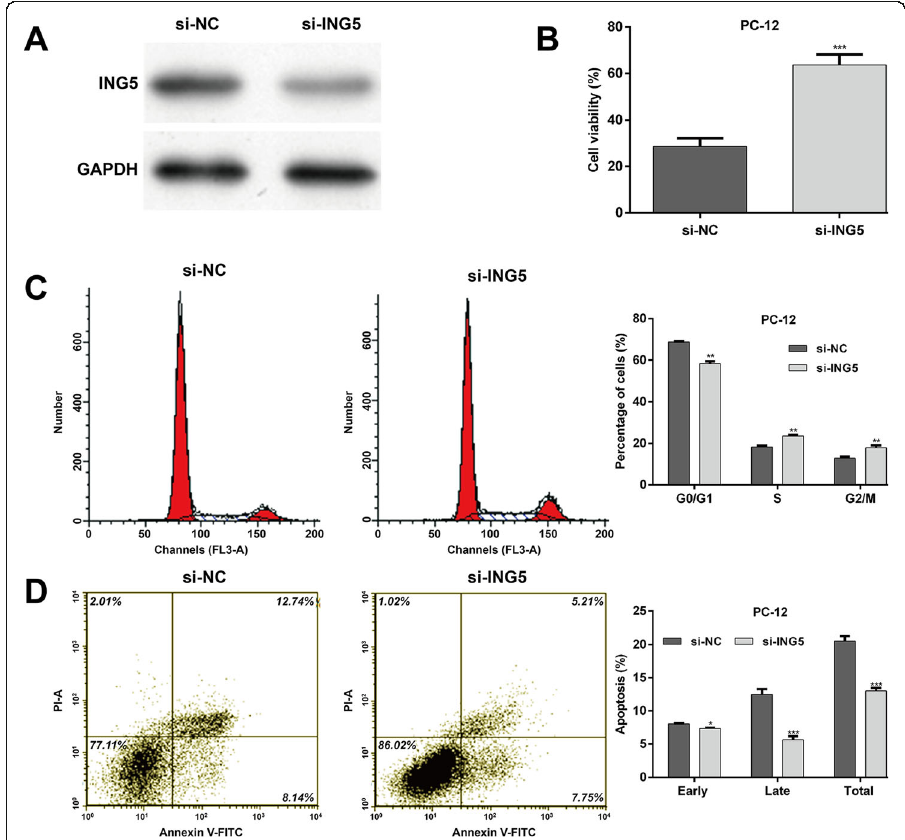
Fig. 4 Knockdown of ING5 imitated the protective effect of miR-376c-3p against OGD-induced injury. PC-12 cells were transfected with si-ING5 or si-NC and then subjected to OGD. ( a ) The protein expression of ING5 was measured in PC-12 cells. ( b ) Cell viability was measured using the CCK-8 assay. ( c ) Cell cycle distribution was analyzed using flow cytometry with PI staining. ( d ) Cell apoptosis was examined using flow cytometry with Annexin V/PI double staining. *p < 0.05, **p < 0.01, ***p < 0.001 vs.